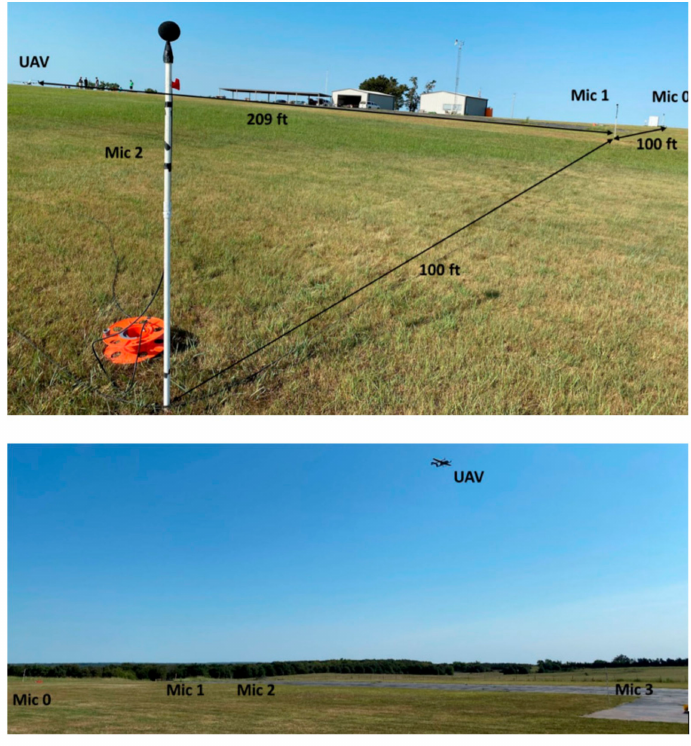
Figure 11. Microphone configuration for VTOL flight acoustic emissions